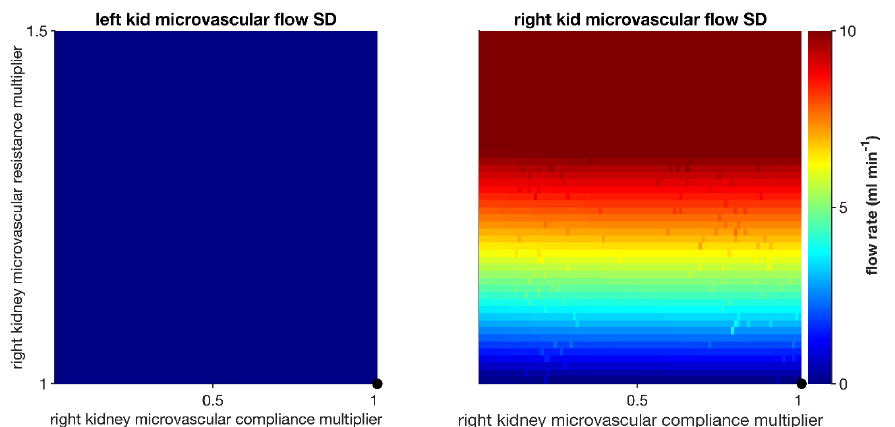
Figure 9. Mean standard deviation of blood flow in renal microvasculature representing blood flow heterogeneity. The left kidney ( left panel ) was seen to receive uniform blood flow, while the right kidney’s ( right panel ) microvascular blood flow was seen to be heterogeneous. See Section 2.4 for details, and results section for an expanded description of the result.